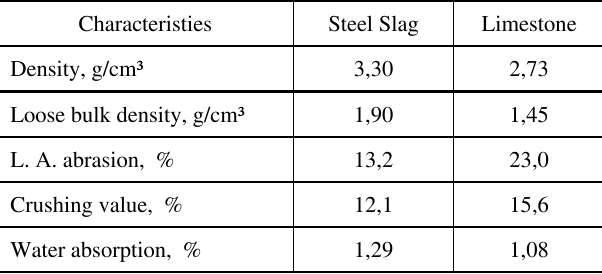
Table 1. Technical properties of steel slag and natural aggregates Characteristies